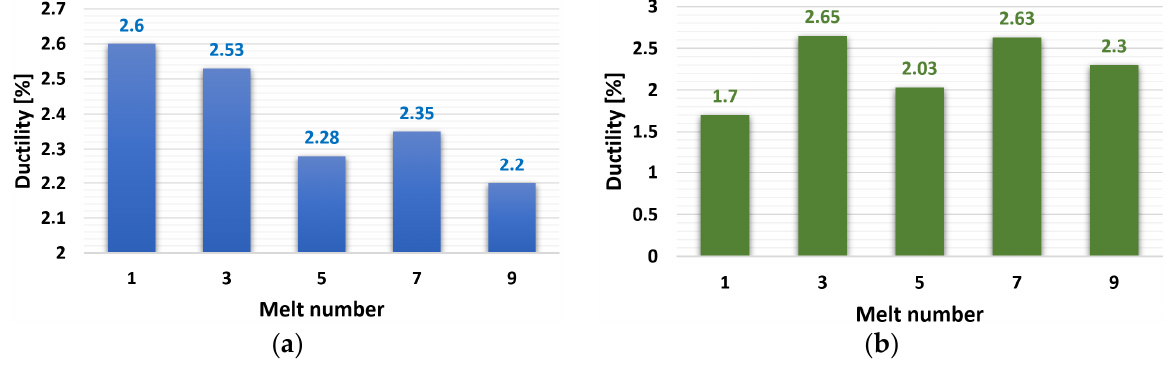
Figure 5. Dependence of ductility on the number of remelts: ( a ) ZnAl4Cu3-P1 to P9 alloys and ( b ) ZnAl4Cu3 with 3 wt.% Cd addition C1 to C9 alloys.